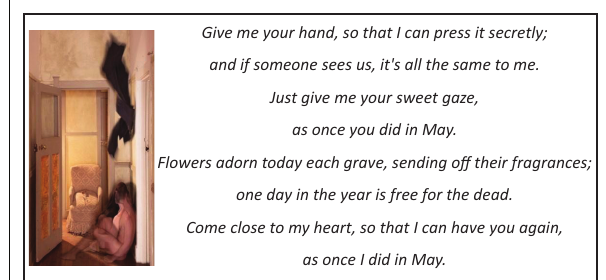
FIGURE 2: Allerseelen : ‘The Door’.